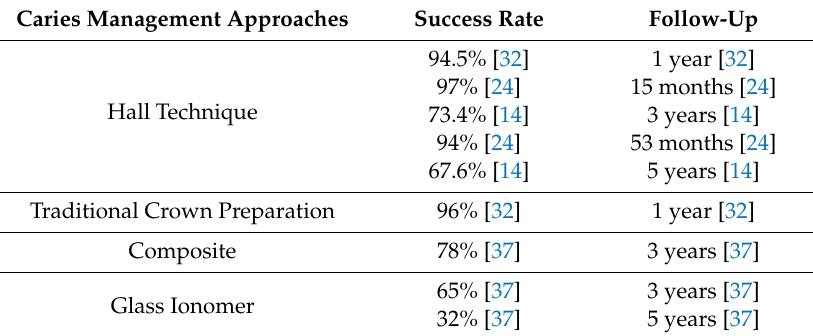
Table 4. Success rate success rates of di ff erent caries management